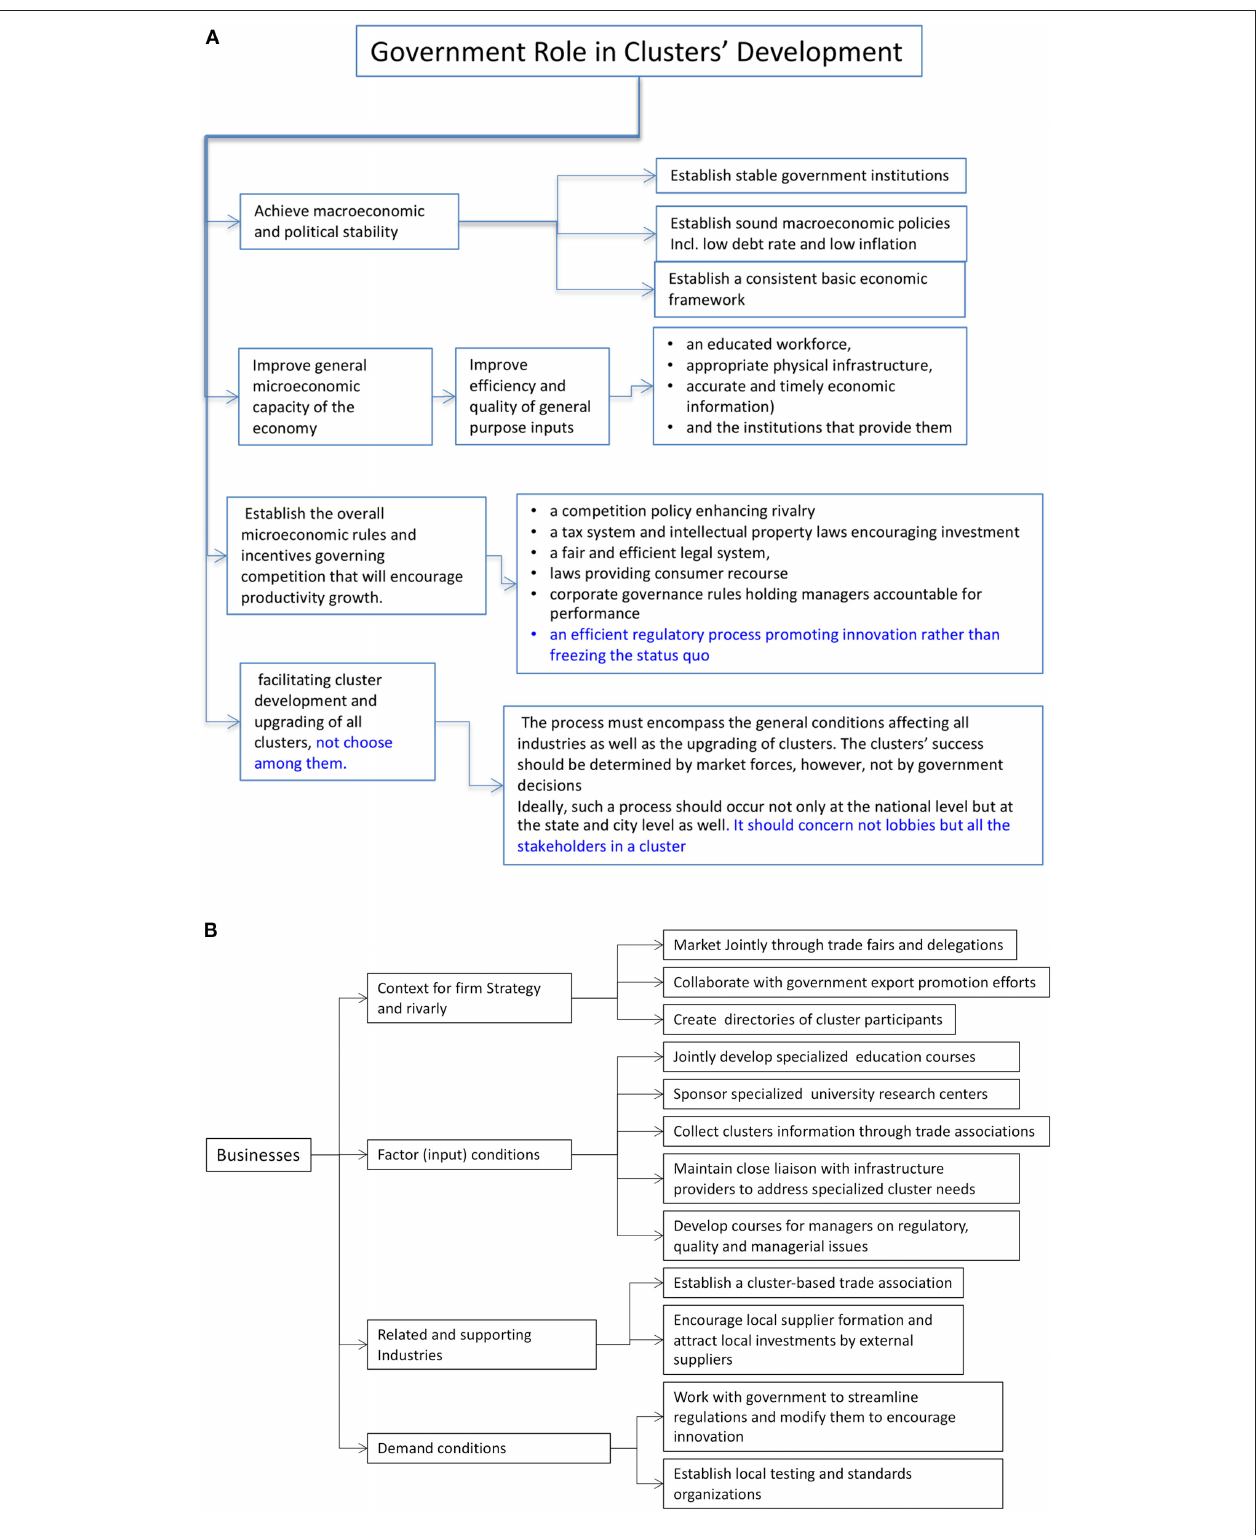
FIGURE 1 | (A) Government role in Clusters’ Development. (B) Corporate role in Clusters’ Development. Source: Porter (1998).